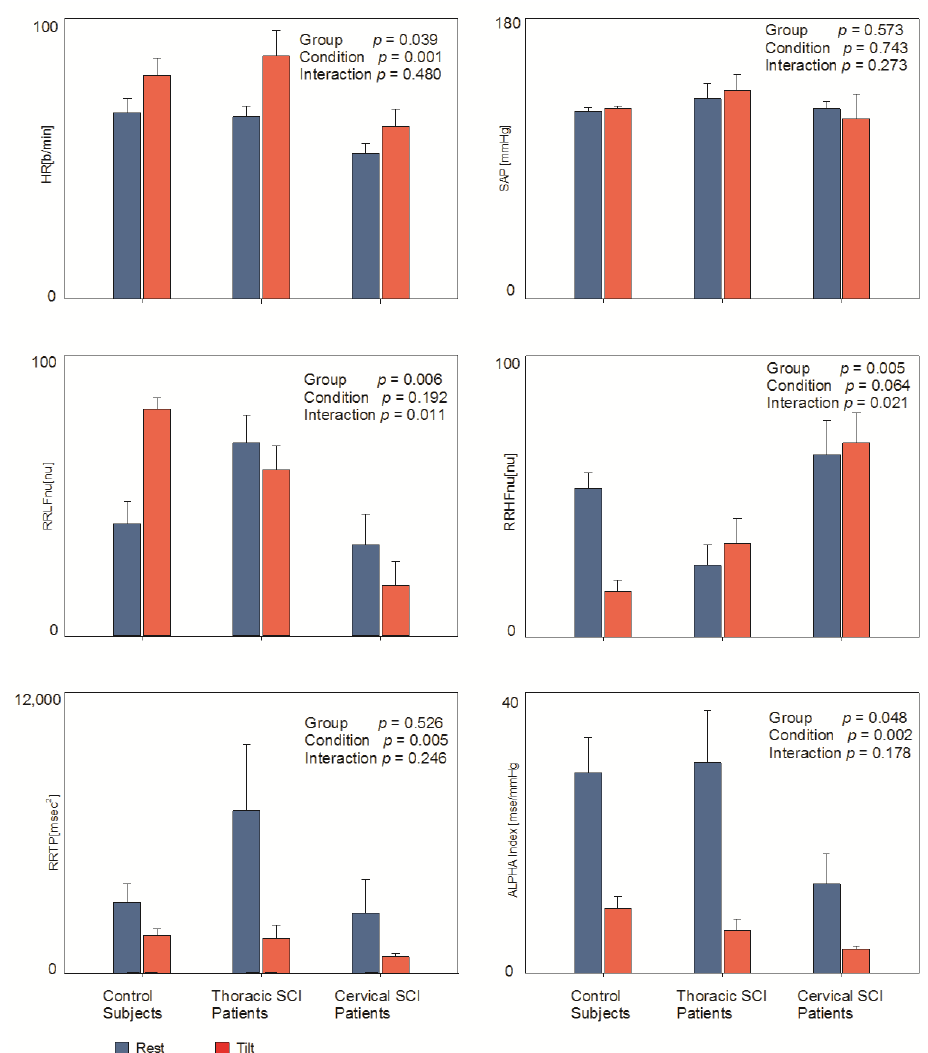
Figure 2. Hemodynamic and autonomic indices in the three examined groups (controls; thoracic and cervical Spinal Cord Injury) during rest and passive orthostatism (tilt). Results of mixed model analysis are indicated in individual panels.